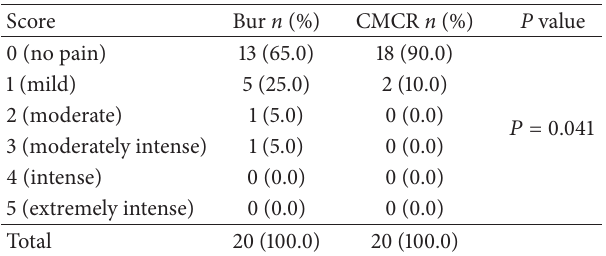
Table 2: Frequency of scores given by children for pain intensity using face scale.